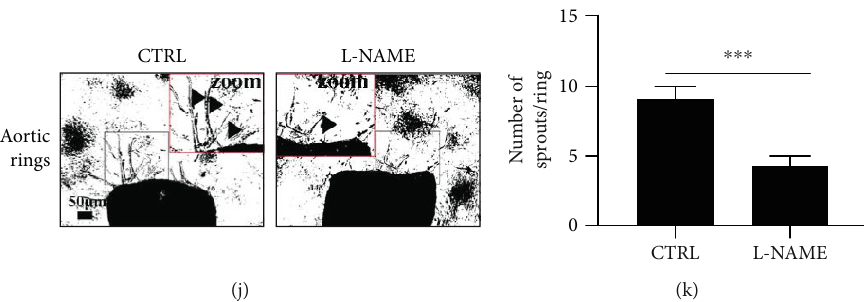
Figure 6: Inhibition of the eNOS activity weakened CD137 signaling-mediated angiogenesis in vitro and ex vivo. (a) The p-eNOS protein level was detected by western blot after treatment with di ff erent concentrations of L-NAME (0, 25, 50, 100, 200, and 300 μ M) for 24 hours. (b) The p-eNOS protein relative level was standardized by β -actin. (c, e) Treatment with L-NAME before activating CD137 signaling for 3 hours, then the EdU-555 proliferation assay and transwell assay were performed. (d, f) Proliferation and migration cells were detected and counted by red nuclei and the violet cell, respectively. (g) The tube formation of HUVECs was observed after treatment with L-NAME(100 μ M) for 30 min under the CD137 signaling activation. (h, i) Total length of tubes and number of branch points, scale bar = 200 μ m . (j) Aortic rings sprouting after pretreatment with L-NAME(100 μ M) for 24 hours before activation of CD137. (k) Number of sprouts per ring(black arrows) was quanti fi ed by Image-Pro Plus 8.0, scalebar = 50 μ m , n = 3